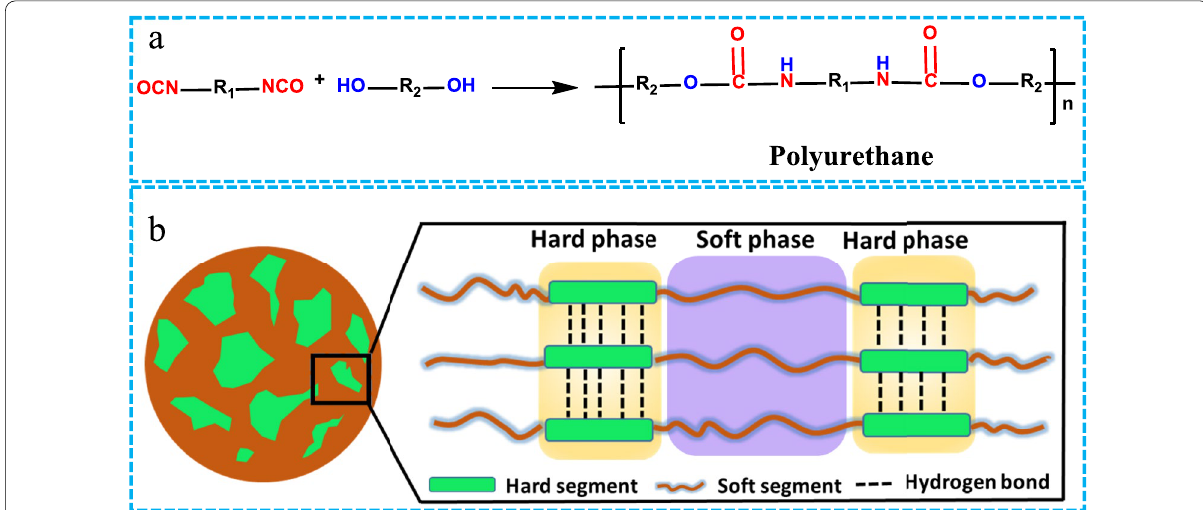
Fig. 1 a Schematic diagram of a simple polyurethane synthesis route. b Microphase separation structure of the